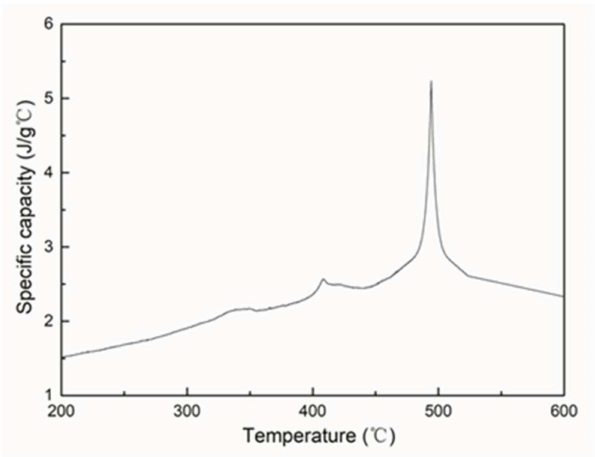
Figure 7. Specific heat capacity curve of